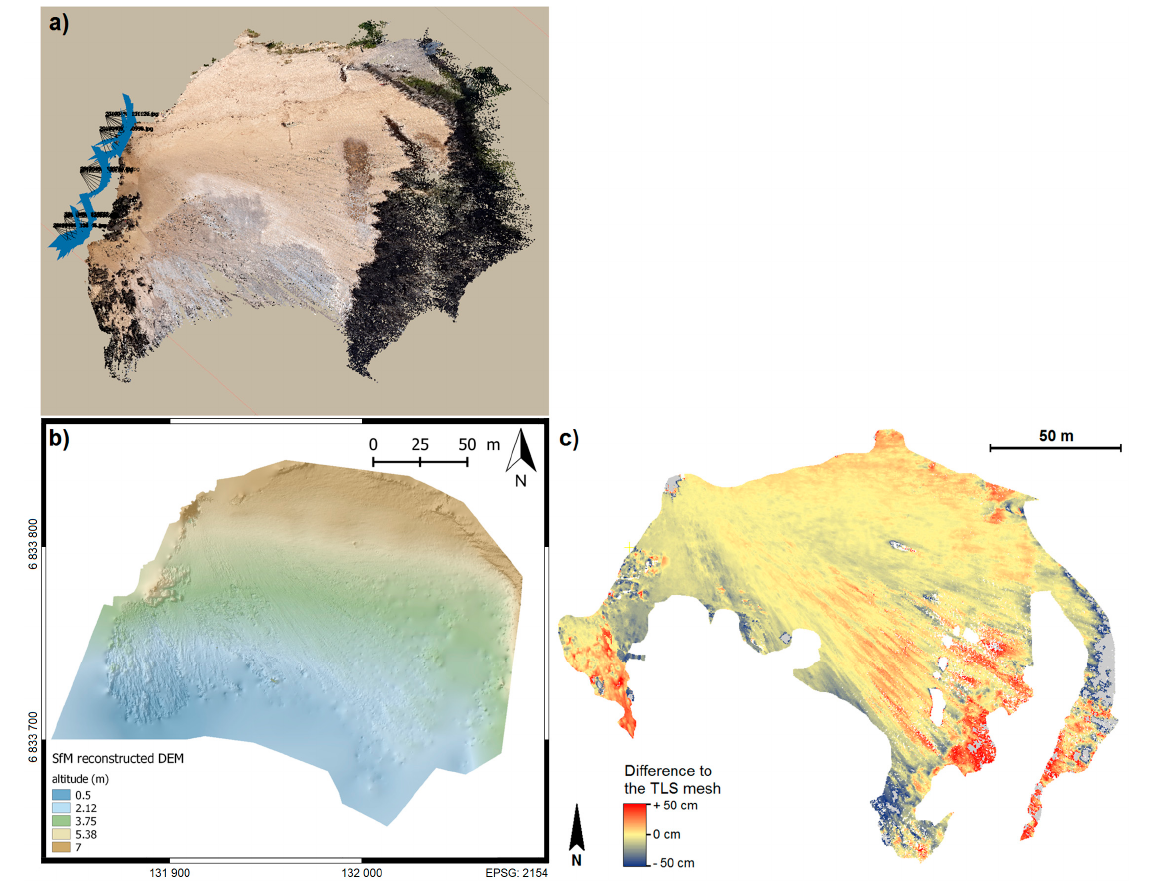
Figure 9. ( a ) SfM dense point cloud obtained in Porsmilin Beach from 5 capturing positions at the top of the western cliff (survey using Galaxy S7 ). ( b ) Porsmilin Digital Elevation Model (DEM) obtained from the point cloud. ( c ) Spatial distribution of the difference between the SfM point cloud and the TLS mesh.